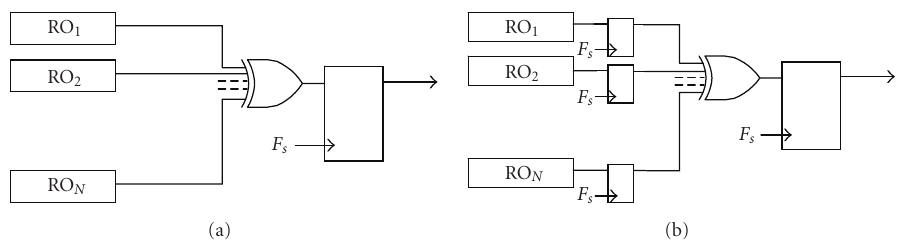
Figure 1: Original TRNG architecture of Sunar et al. (a) and modified architecture of Wold and Tan (b).